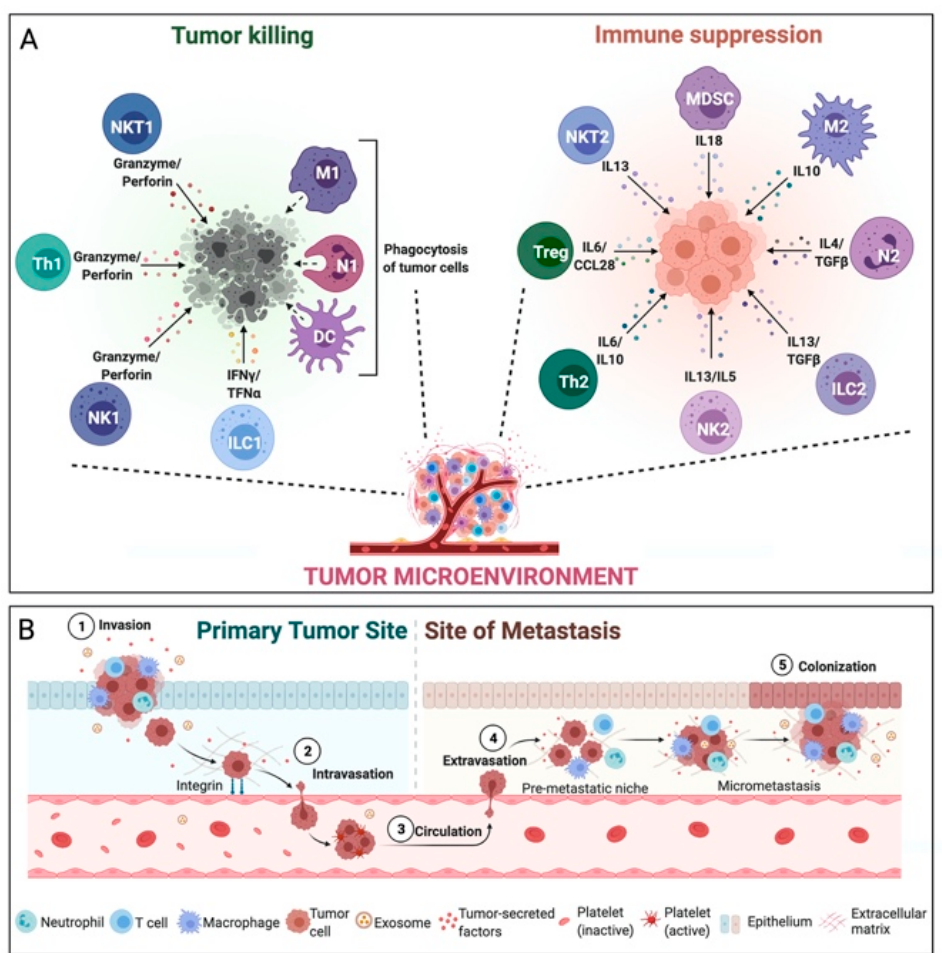
Figure 1. Simplified schematic representation of the tumor microenvironment. ( A ) Schematic representation of immune cells in tumor microenvironment that have an anti-tumorigenic effect (natural killer and tumor-infiltrating lymphocytes) and of other tumor-infiltrating immune cells that have a pro-tumorigenic effect (CD4 + T helper lymphocytes 2 (Th2), the regulatory CD4 + T-lymphocytes (Treg)). ( B ) schematic representation of immune cells role in tumor spreading process. Second, tumor-infiltrating immune cells play a more ambivalent role and may as well have an anti-tumorigenic or a pro-tumorigenic effect based on a delicate balance of different mechanisms within the TME. Namely, other TILs can exhibit a pro-tumorigenic effect, such as CD4 + T helper lymphocytes 2 (Th2), producing interleukins with an inflammatory effect, and the regulatory CD4 + T-lymphocytes (Treg), which are indispensable for maintaining homeostasis, down-regulating the CD8 + T-lymphocyte activity [1,6]. Also, the presence of tumor-associated macrophages (TAMs) is related to a poor prognosis and reduced overall survival (OS). TAMs phenotype can be polarized by the TME characteristics, resulting in the development of pro-inflammatory macrophages (M1 type, driven by IFN γ and tumor necrosis factor-alpha (TNF α ) or anti-inflammatory macrophages (M2 type, driven by IL4 and IL13). While the former ones have an anti-tumorigenic effect, the latter ones promote tumor progression by stimulating angiogenesis, remodeling the ECM, promoting metastasis and immunosuppression [1,3,5,7,8]. Tumor-associated neutrophils (TANs) may also show a similar behavior: they can be polarized, resulting in the development of an anti- tumorigenic type (N1) or a pro-tumorigenic type (N2). Driven by the action of transforming growth factor-beta (TGF- β ) secreted by the CAFs, N2 stimulate cancer proliferation and migration through the secretion of matrix metalloproteinases (MMPs) and IL1 β [3,4,9]. Finally, the role of tumor-infiltrating B cells (TIBs) is even more controversial: CD20 +